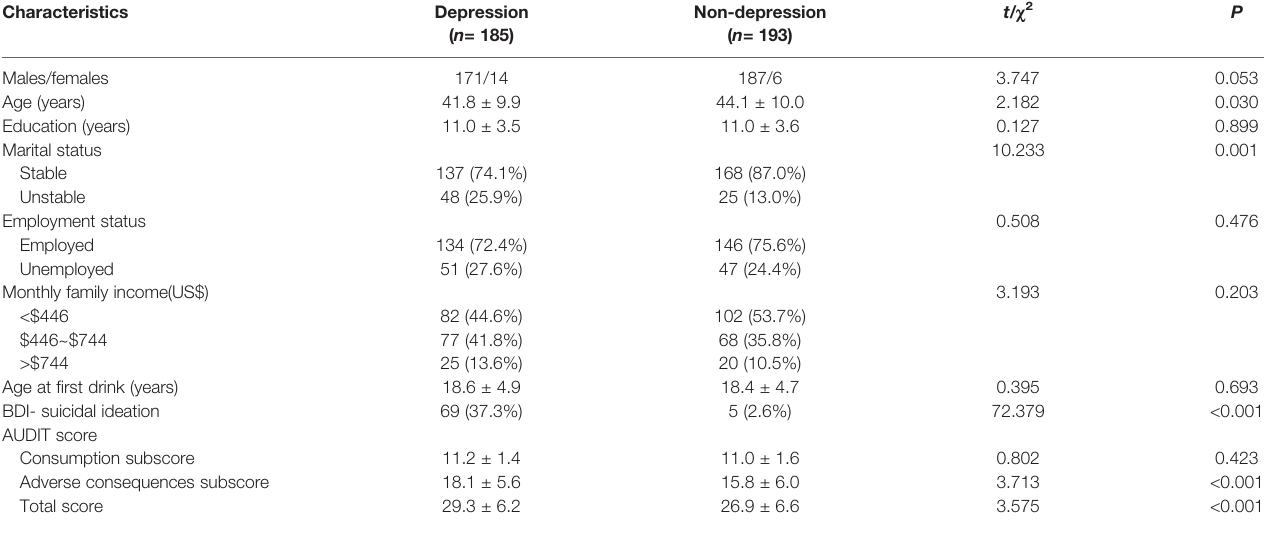
TABLE 1 | Demographic and clinical features between the alcohol dependence (AD) patients with and without depression.